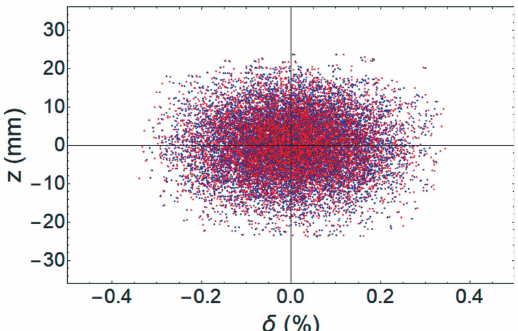
Figure 6 Comparison of the original longitudinal profile at the crab cavity position (blue dots) and re-projection from equation (5) (red dots). No wakefield